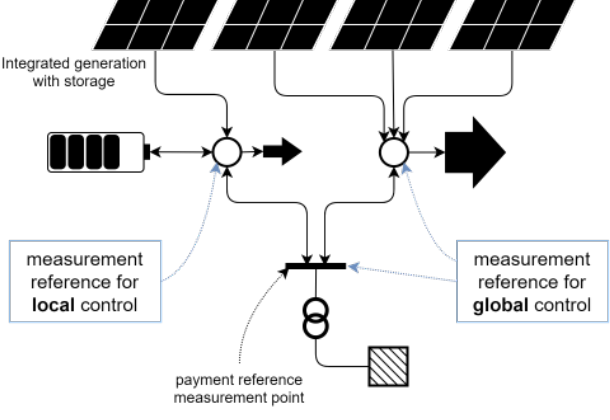
Figure 13. Global and local vision for control